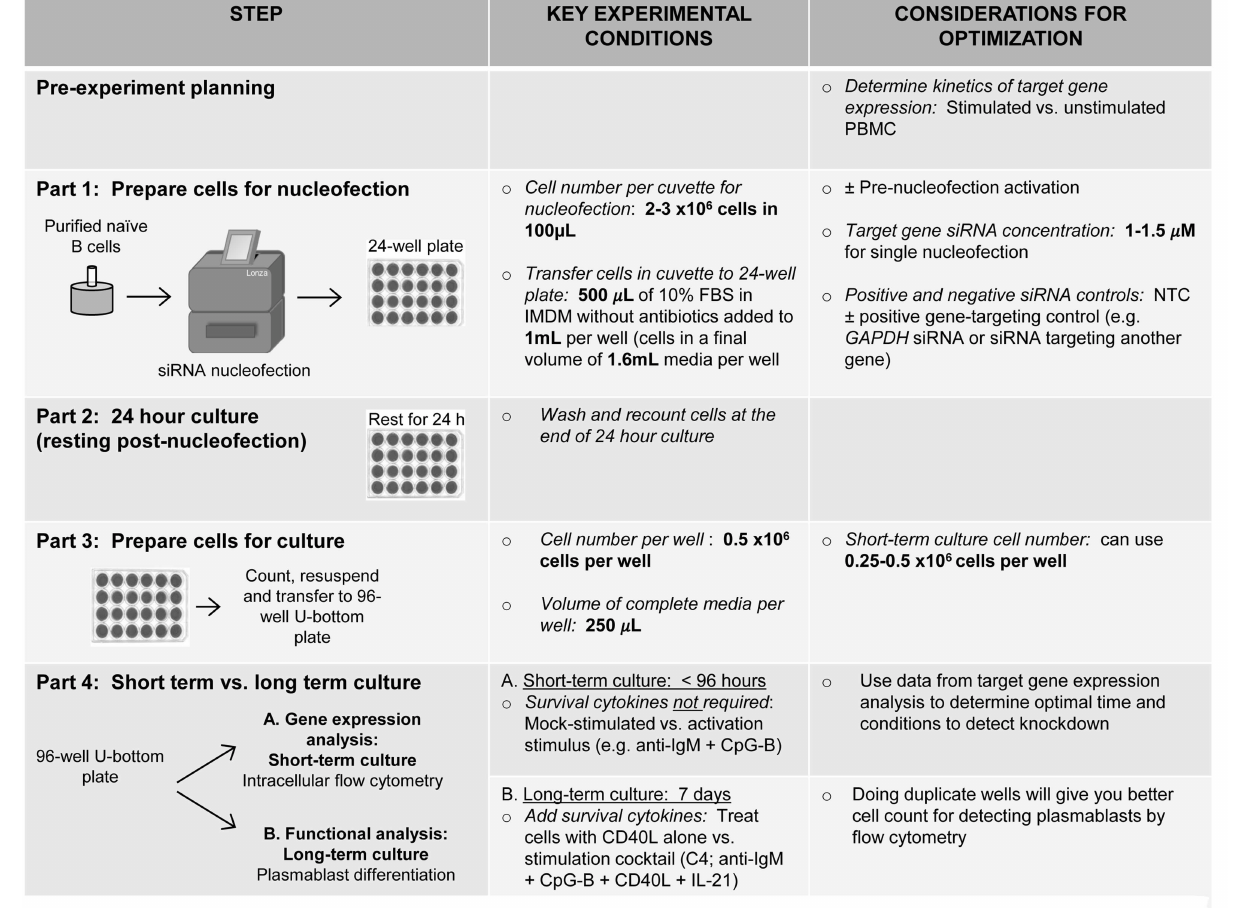
FIGURE 8 | Schematic summarizing an optimized method for RNAi knockdown in primary human naïve B